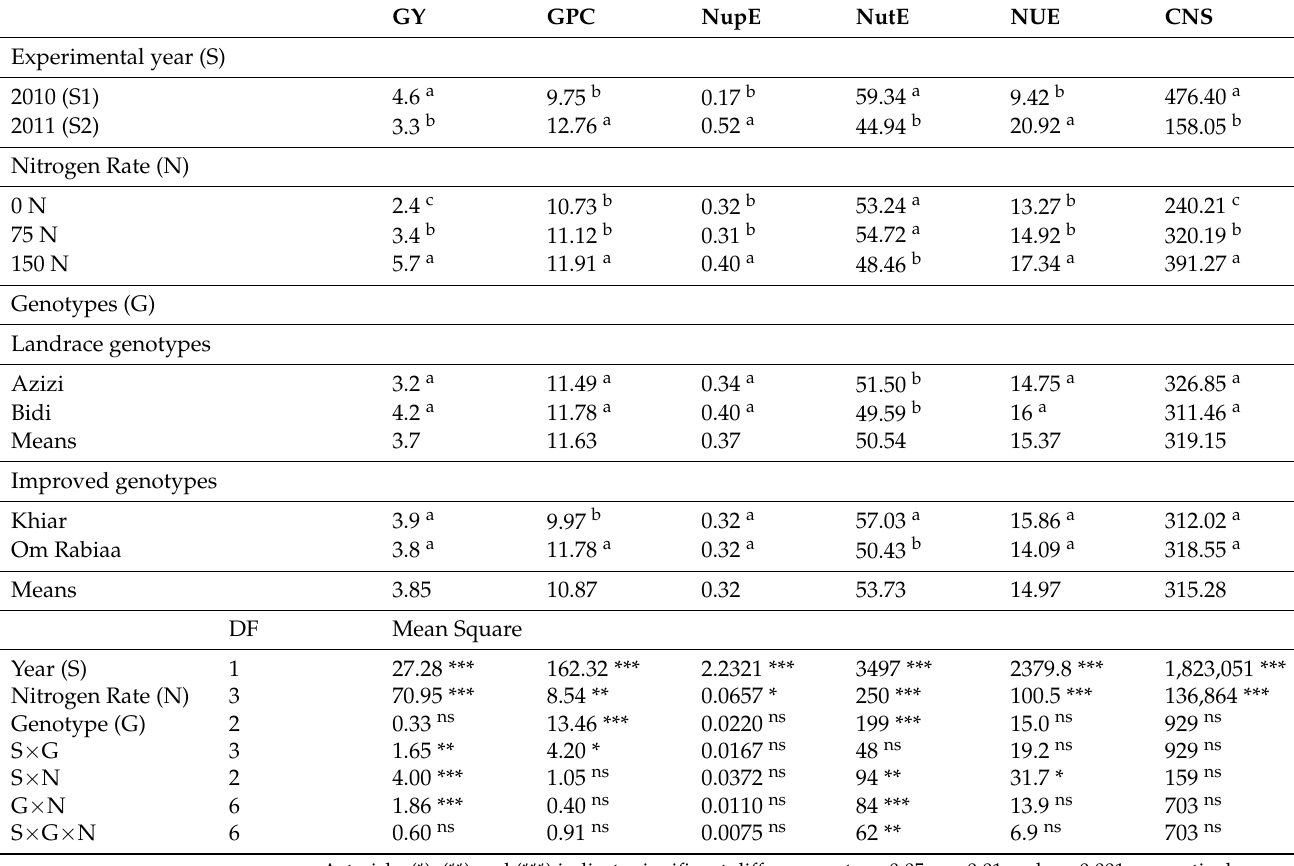
Table 3. Mean squares of grain yield (GY; t ha − 1 ), grain protein content (GPC; %), nitrogen